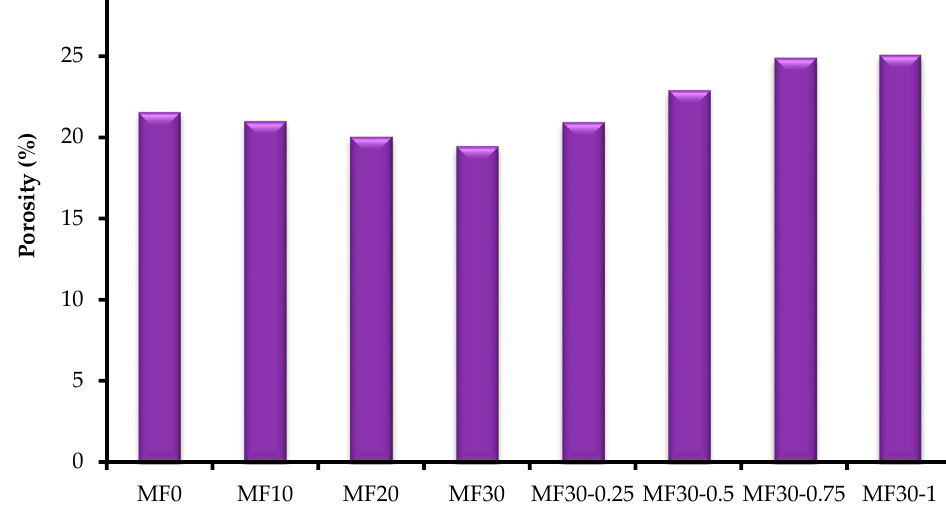
Figure 9. Concrete Figure 9. Concrete porosity.